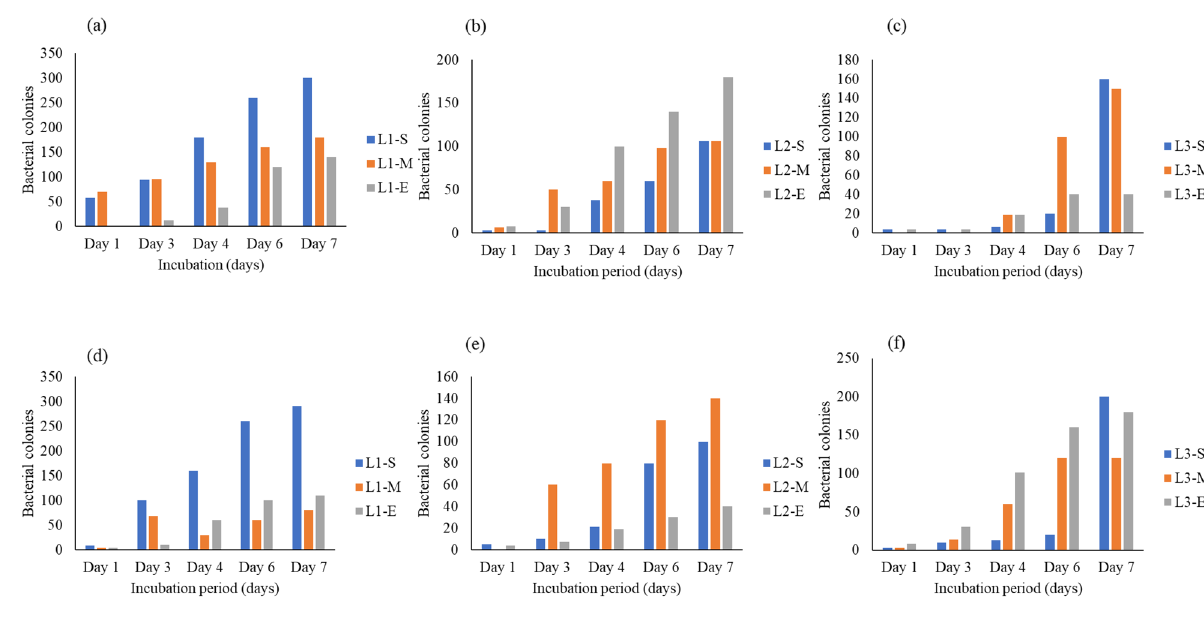
Figure 8. Bacterial colony growth for deposited sediment (DS) ( a ) colony growth under AF for lateral 1 (L1), ( b ) lateral 2 (L2), and ( c ) lateral 3 (L3). Bacterial growth on adhered bacterial biofilm (ABF) for ( a ) L1, ( b ) L2, and ( c ) L3. *L ( i = 1, 2, 3) S start section of lateral, M mid-section of lateral, E end section of